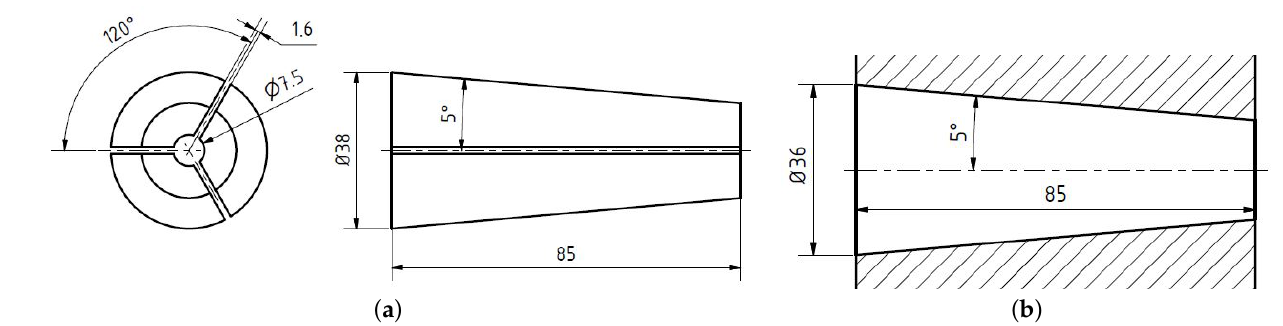
Figure 4. Sketches of the modeled wedges and the barrel. ( a ) Geometry of the wedge; ( b ) inner contour of the barrel.